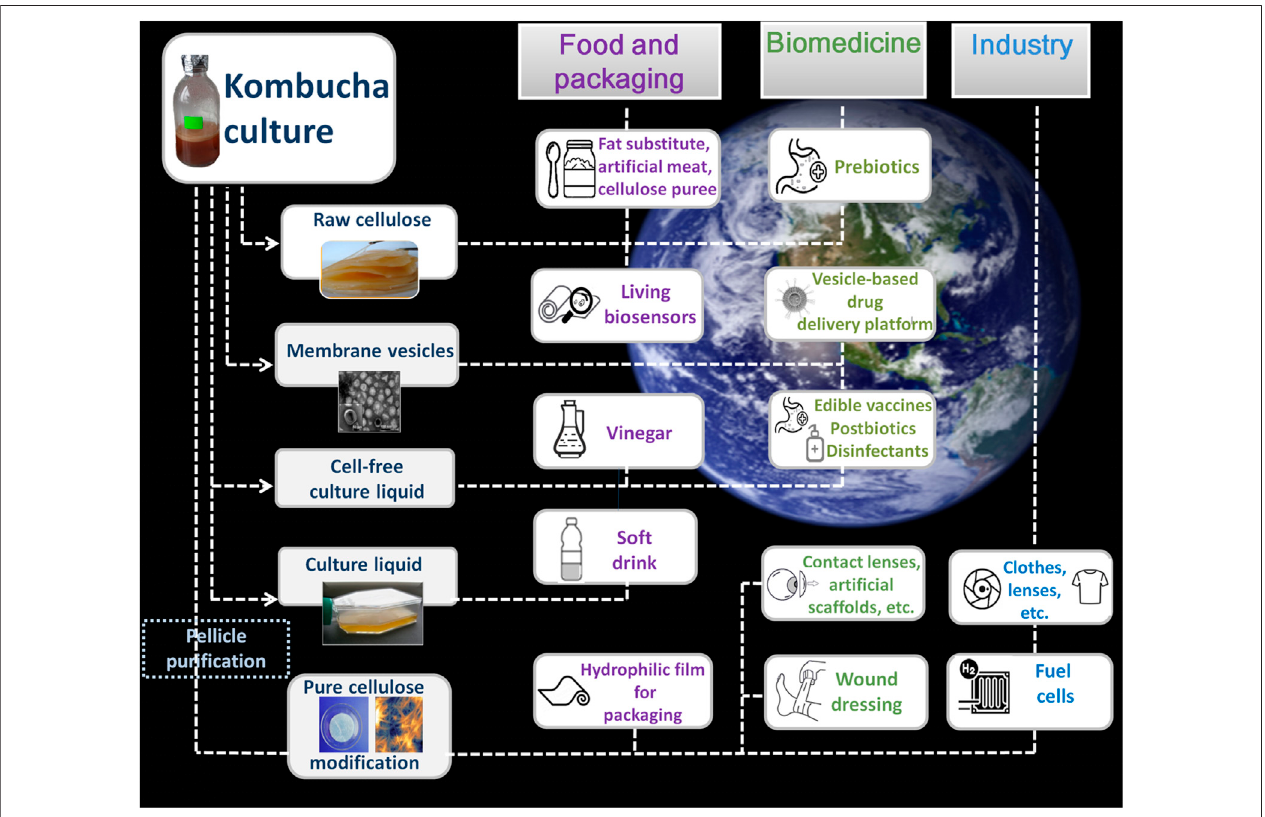
FIGURE 1 | Kombucha ’ s cellulose-based pellicle as a three-dimensional hub for microbial community-member cells and raw material for fermented food and consumer goods fabrication. Background image credits: ESA.